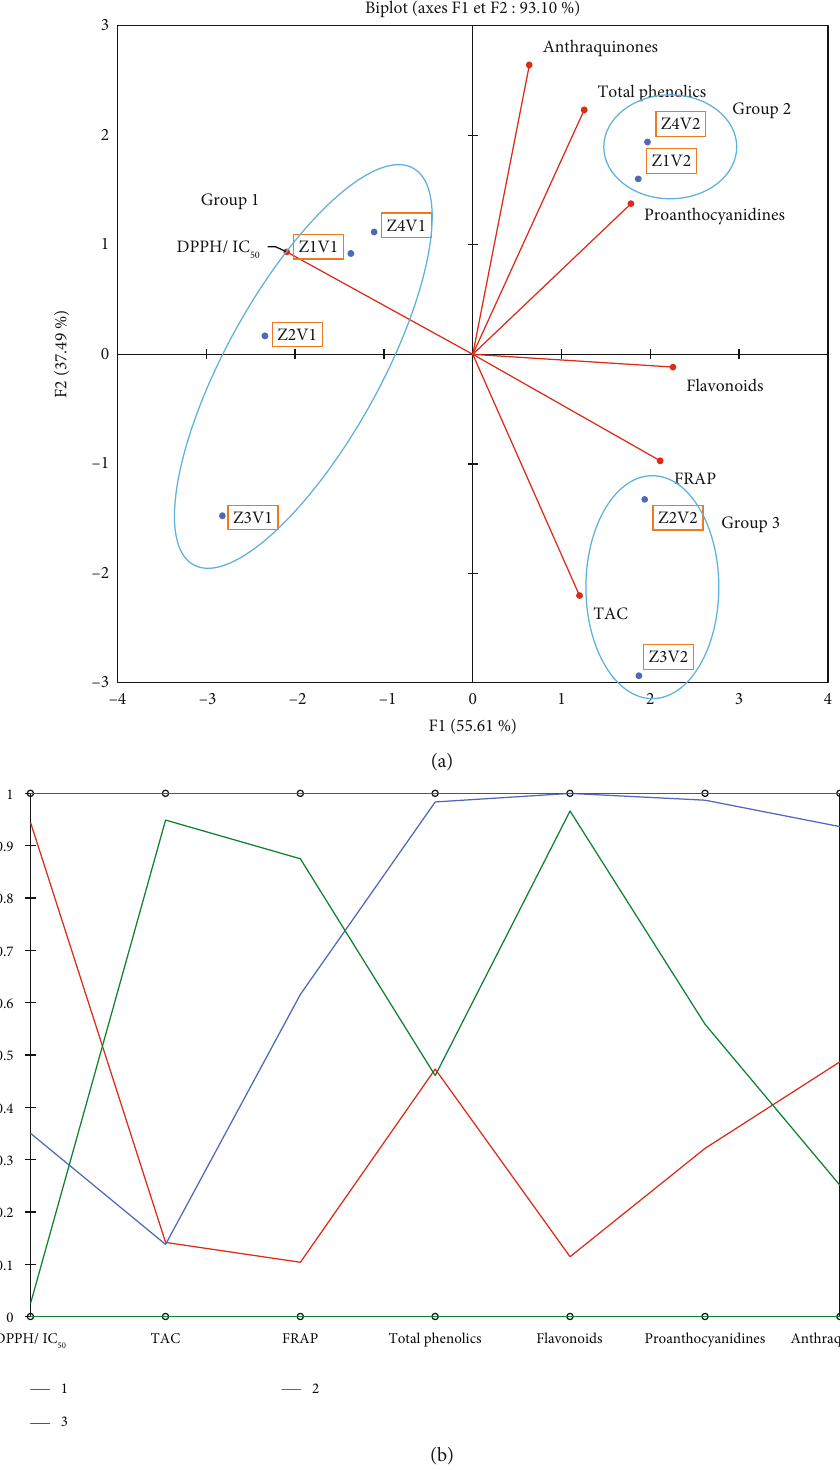
Figure 1: Distribution of Ipomea batatas leaf powder and measured parameters on the principal component analysis F1 ∗ F2 axis plane (a). Pro fi les of the di ff erent groups of I. batatas leaves (b). (Legend. Z1V1: yellow I. batatas IRAD-Tib1 collected from Garoua; Z2V1: yellow I. batatas IRAD-Tib1 collected from Ngaoundere; Z3V1: yellow I. batatas IRAD-Tib1 collected from Foumban; Z4V1: yellow I. batatas IRAD-Tib1 collected from Ba fi a; Z1V2: white I. batatas IRAD-1112 collected from Garoua; Z2V2: white I. batatas IRAD-1112 collected from Ngaoundere; Z3V2: white I. batatas IRAD-1112 collected from Foumban; Z4V2: white I. batatas IRAD-1112 collected from Ba fi a; 1: group 1; 2: group 2; 3: group